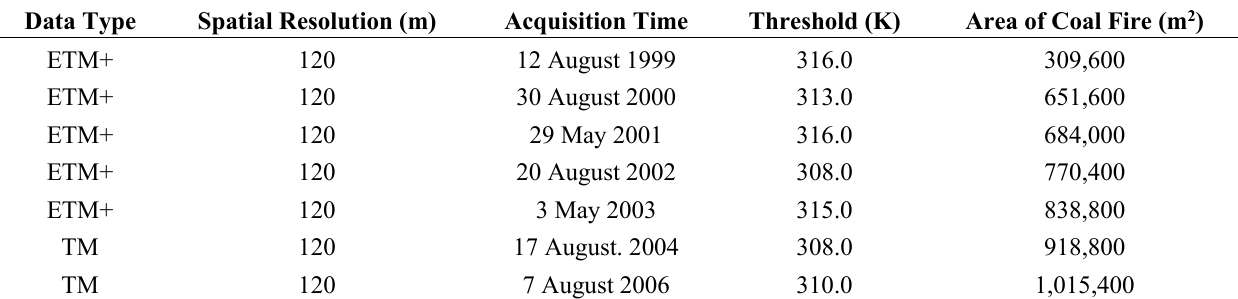
Table 4. Threshold for coal fire mapping and the corresponding area based on satellite